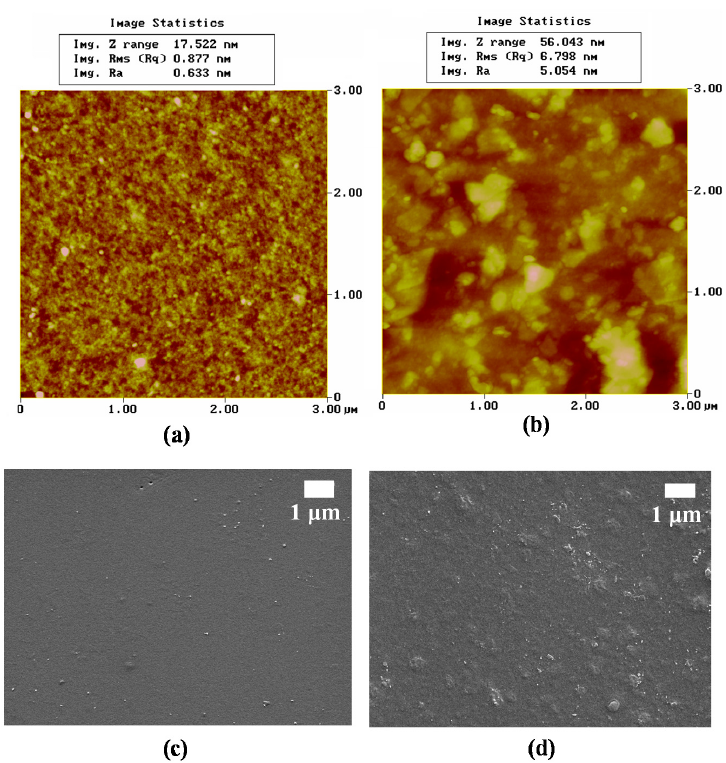
Figure 4. ( a , b ) AFM and ( c , d ) SEM images of CS- g -PLLA(80 / 20) ( a , c ) and CS- g -PLLA(50 / 50) ( b , d ).